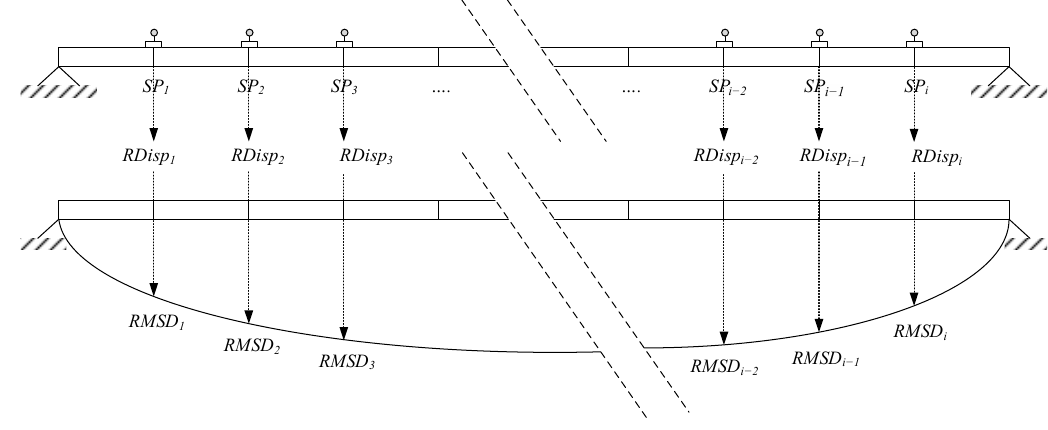
Figure 7. Illustration of sensor points and damage index 1.